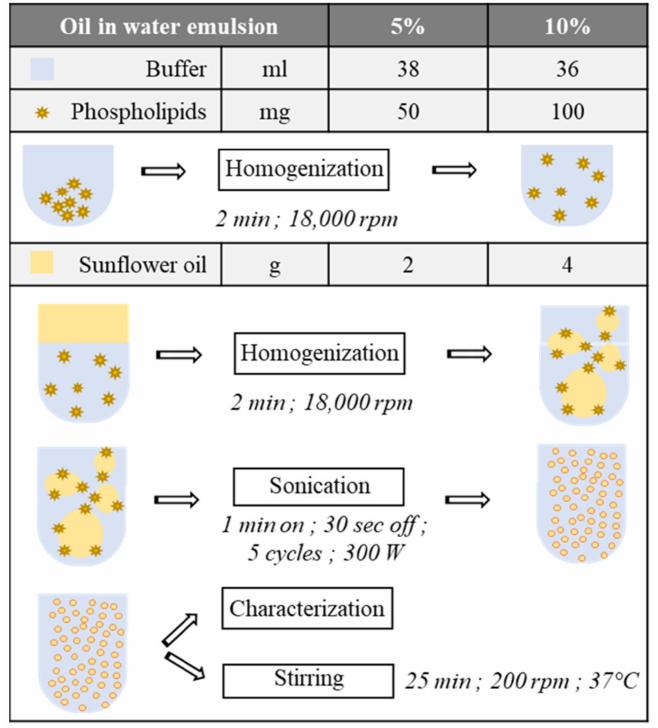
Figure 1. Fabrication process of the emulsified screening medium, with 5% or 10% of oil in